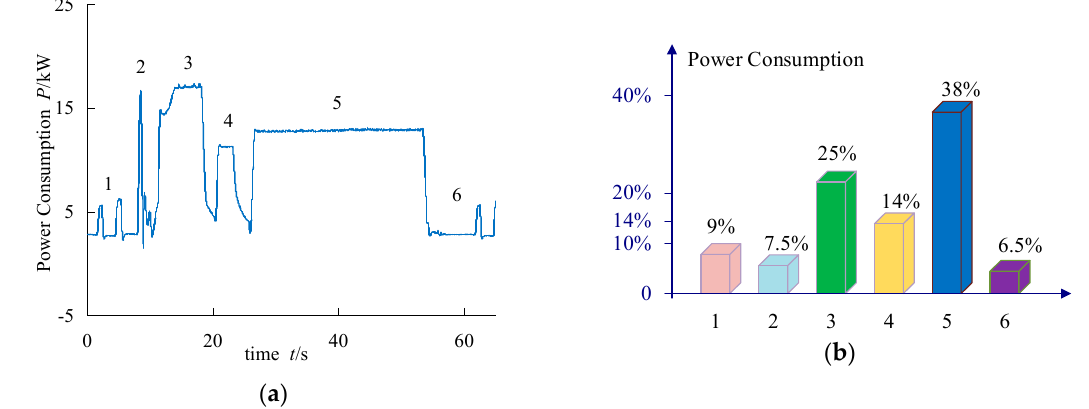
Figure 3. The distribution of power consumption of a hydraulic injection-molding machine (IMM) in a work cycle: ( a ) The power curve, ( b ) The distribution of power consumption